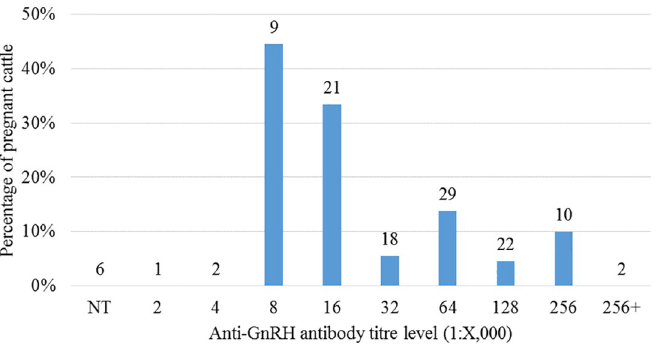
Fig 2. Percentage of treated cattle pregnant in relation to anti-GnRH antibody titres across all years post-booster. N = total number of samples at each titre level. NT = no detectable titre. Group sample size indicated on each bar.